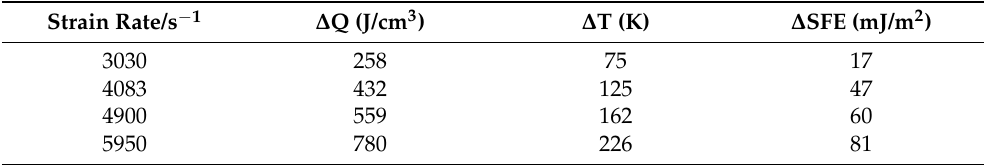
Table 2. The estimated converted heat ( ∆ Q), the temperature rise ( ∆ T), and the stacking fault energy (SFE) increment for different strain rates after dynamic